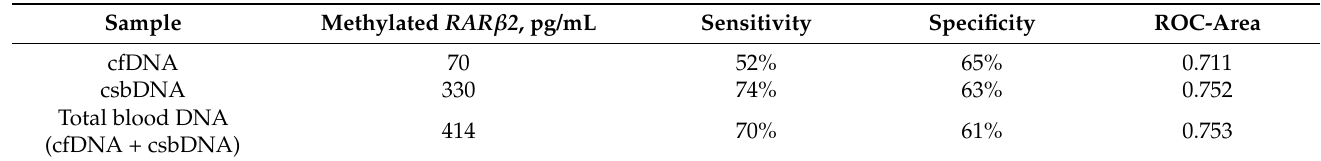
Table 2. ROC area, cut-off value, specificity, and sensitivity for aberrantly methylated RAR β 2 gene in cfDNA and blood